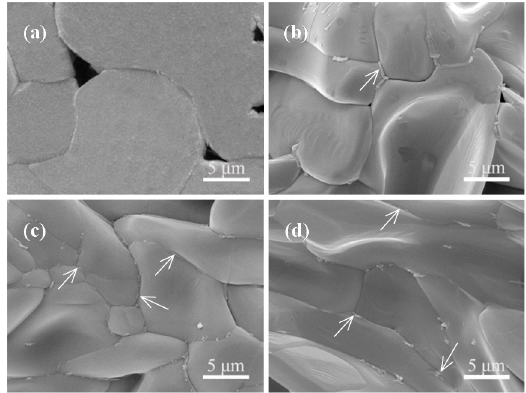
Figure 3. The thermally etched surface of CaSO 4 scaffolds with different amounts of 45S5 bioglass: Table 1. The preparation parameters of scaffolds.